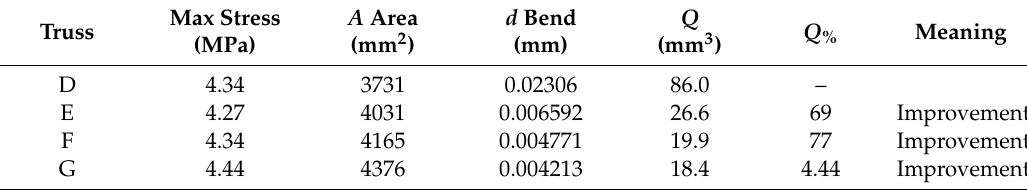
Figure 14. Increasing the number of internal support members of the Michell truss. Table 3. Comparing the influence of the of the number of members in the Michell truss.